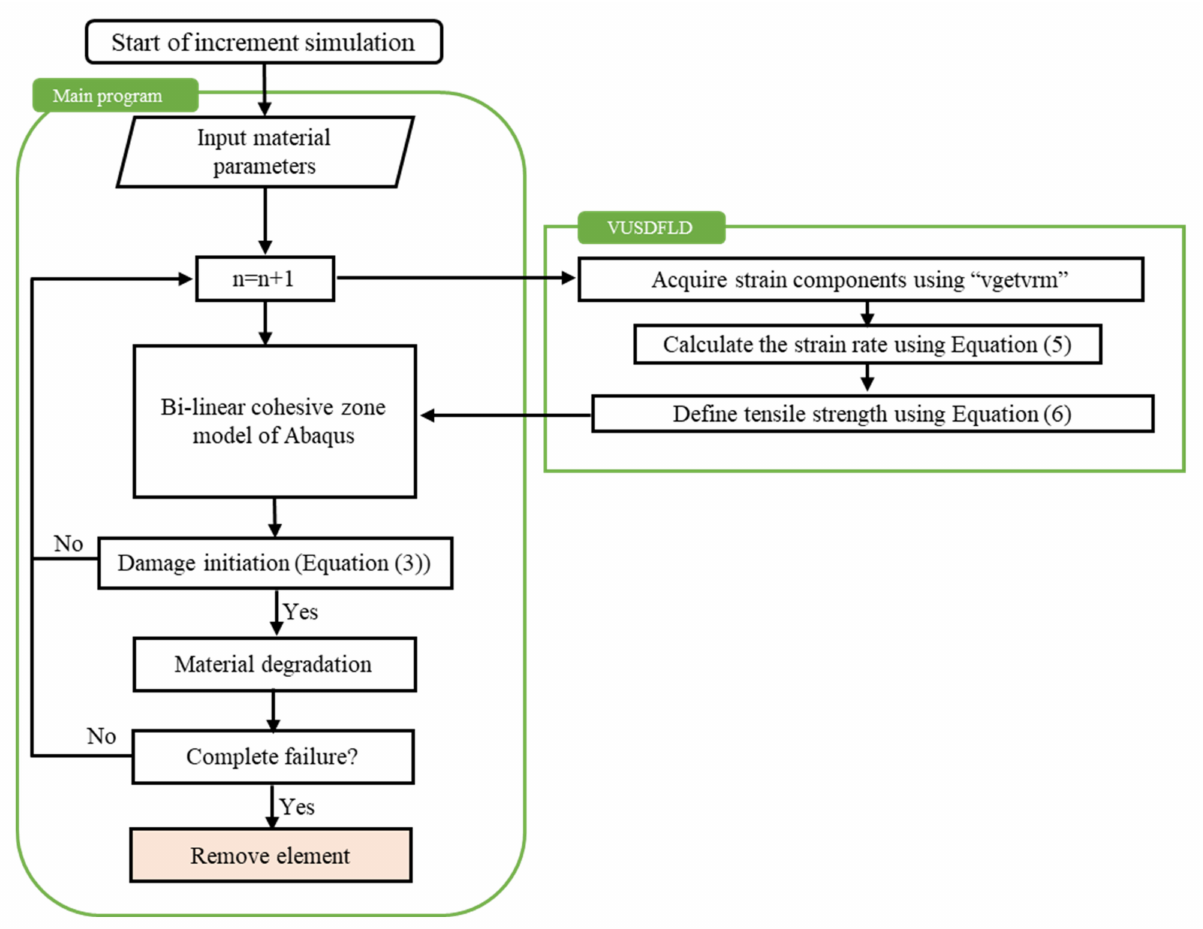
Figure 2. Flowchart of the VUSDFLD